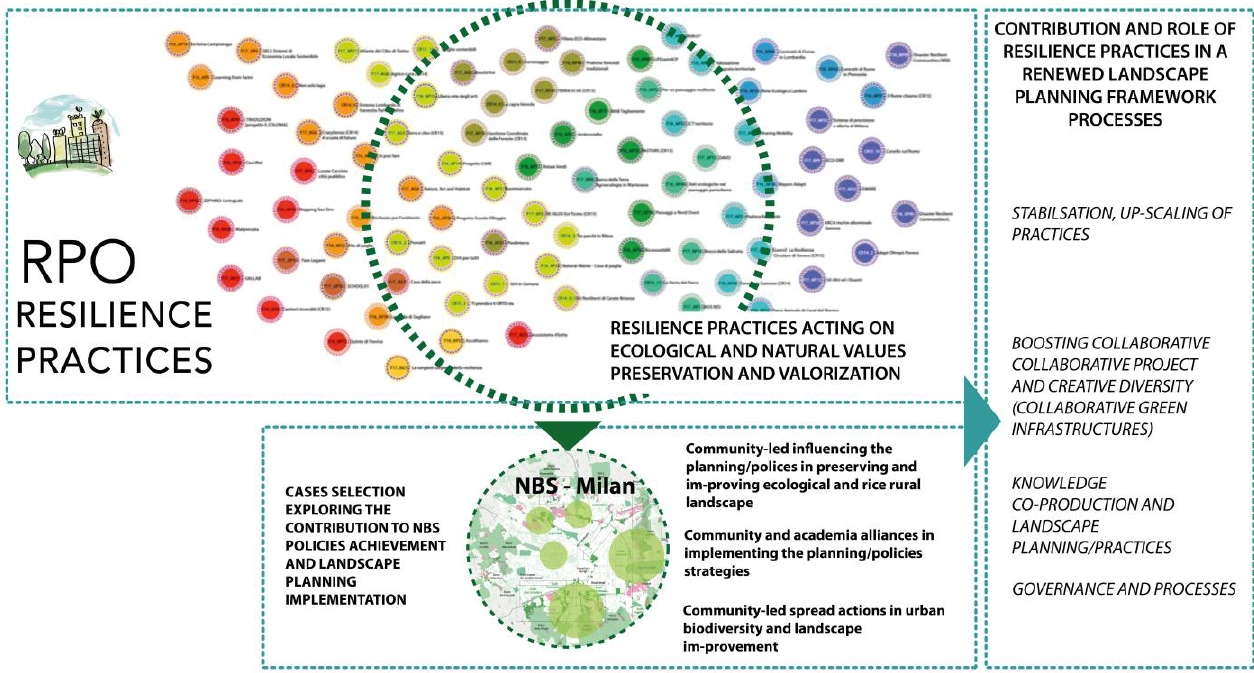
Figure 1. The logical frame of the paper: the focus on the practices acting on improving the environment and ecosystem components of the territorial systems (highlighted in the RPO resilience practices map) and the selection of the three exemplifying cases of recurring dynamics between resilience practices and landscape process planning. The outcomes and emerging perspectives for the disciplinary debate for the collaborative landscaping planning process.